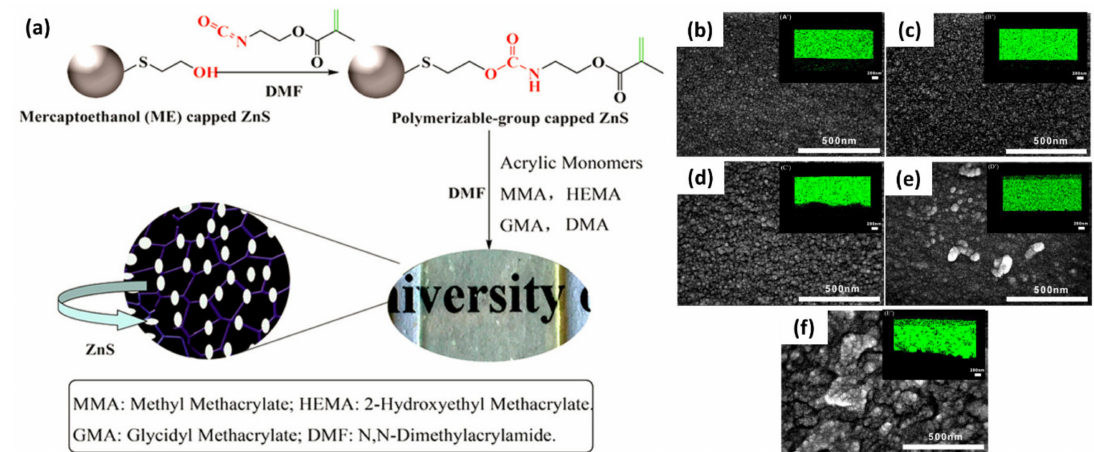
Figure 14. ( a ) Nanocomposite fabrication using ZnS nanoparticles surface-anchored with polymerizable group. ( b – f ) SEM images of hydrogel with di ff erent concentration of the ZnS nanoparticles, and EDS sulfur mapping (insets) for each nanocomposite hydrogel: ( b ) 50 wt%, ( c ) 60 wt%, ( d ) 70 wt%, and ( e ) 80 wt% of polymerizable-group-capped ZnS nanoparticles, and ( f ) 50 wt% physically embedded ME-capped ZnS. (Reproduced with permission from Reference [107]; Copyright (2018)